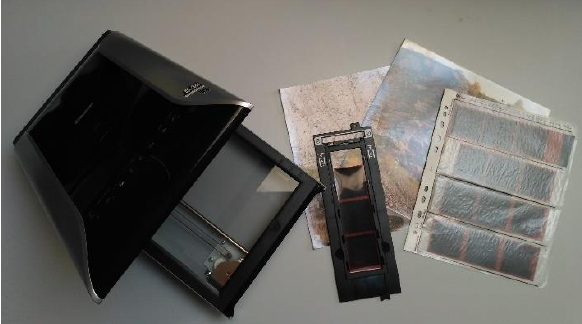
Figure 5. Digitalization of photogrammetric negatives.